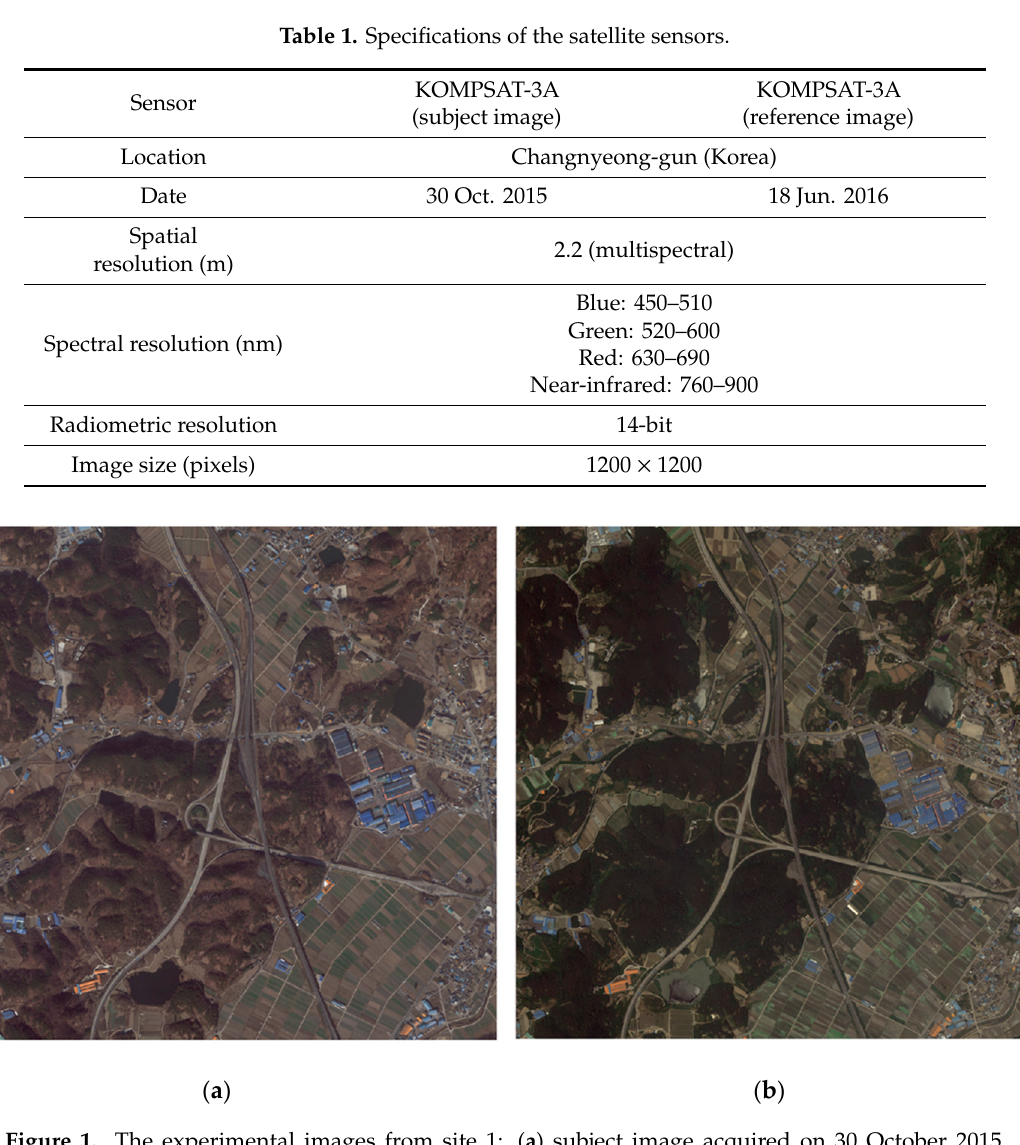
Figure 1. The experimental images from site 1: ( a ) subject image acquired on 30 October 2015, ( b ) reference image acquired on 18 June 2016.